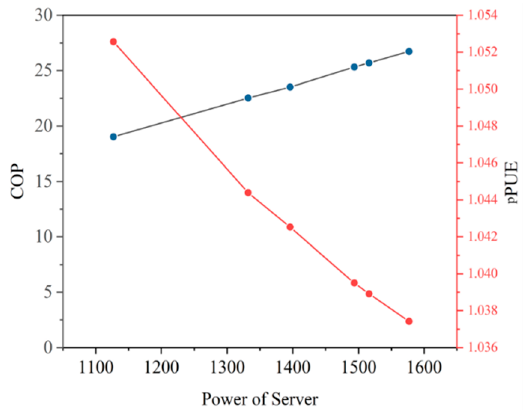
Figure 6. Coefficient of performance (COP) and partial power usage effectiveness (pPUE) of the proposed two-phase cooling system.